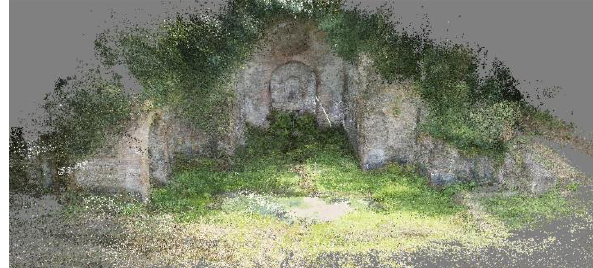
Figure 4. Sparse point cloud of the Nymphaeum of Egeria